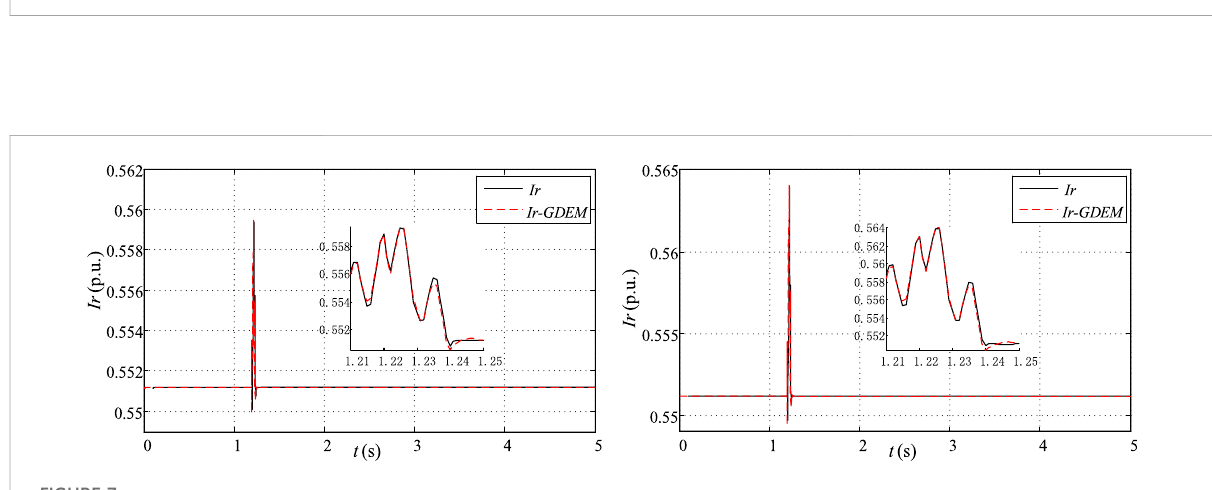
Dynamic characteristic response of the real part of the current with F5 and F6 in operating condition